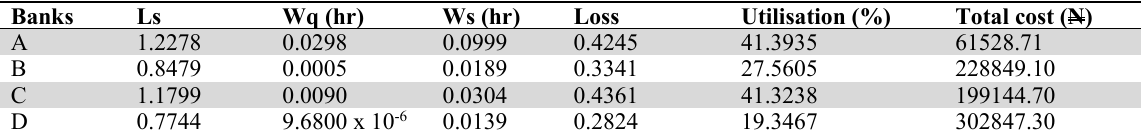
Decision matrix of the study